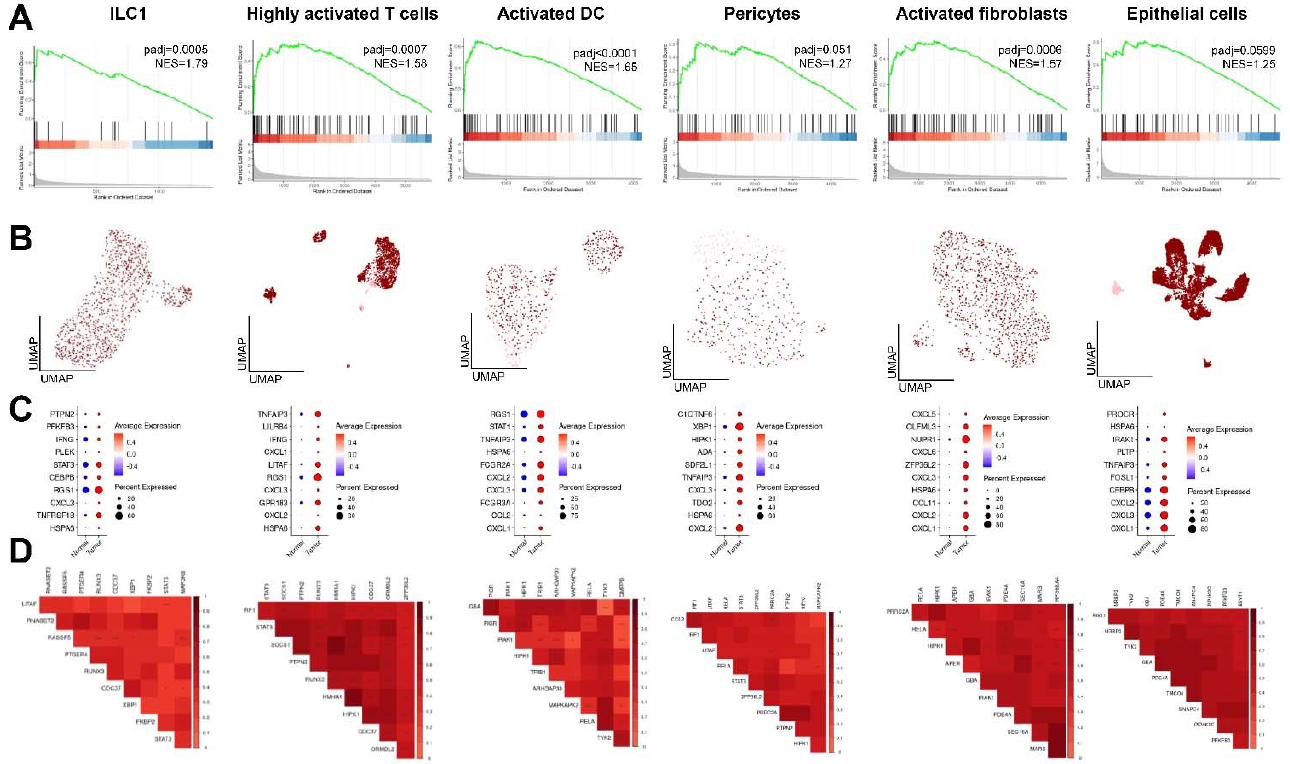
Figure 5. Cell-population-specific induction and co-expression of CD risk genes in sporadic CRC. ( A ) GSEA reveals the statistically significant enrichment of CD-induced genes in ILC1, activated DCs, activated fibroblasts and highly activated T cells isolated from colorectal tumors. ( B ) UMAPs displaying gene expression-based similarities between control (light pink) and transformed (dark red) cells. Pericytes and epithelial cells isolated from tumors appear highly distinct from controls. ( C ) Dot plots depicting genes with the most significant differential expression per cell population. Dot size indicates the percentage of cells expressing the respective genes, dot color represents expression intensity. ( D ) Correlation plots revealing co ‐ expression patterns of CD ‐ induced genes in sporadic CRC.